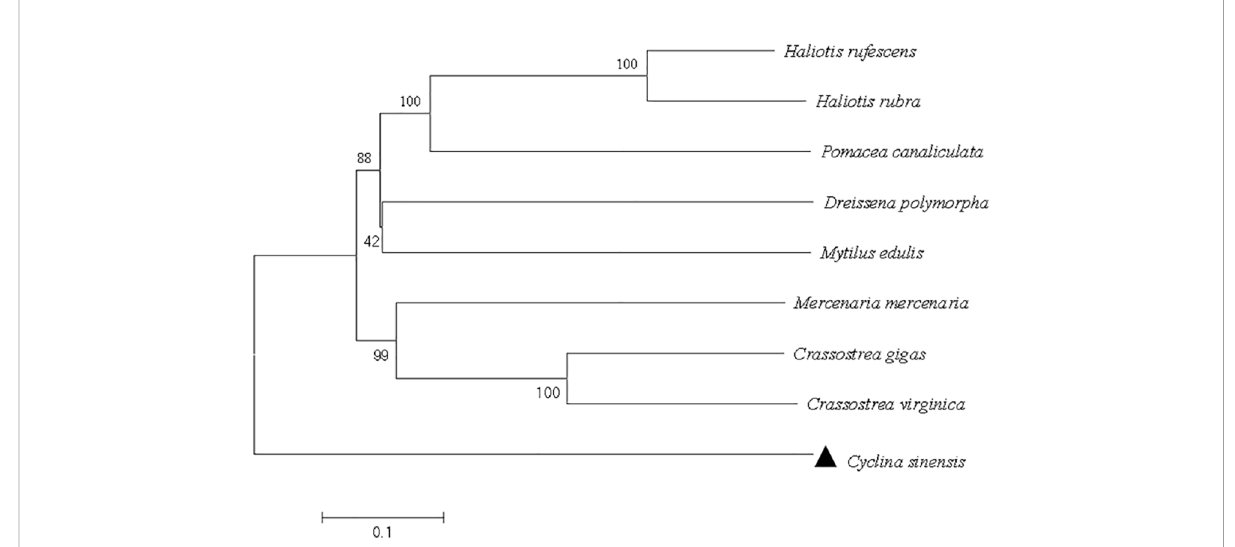
FIGURE 5 Phylogenetic tree derived from multiple alignment of the IFITM1 amino acids from Cyclina sinensis and other species.